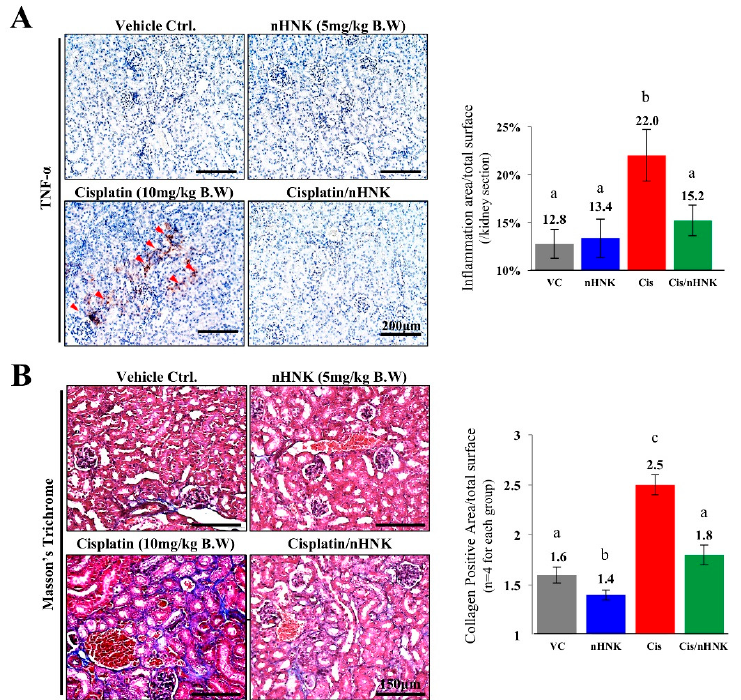
Figure 3. Evaluation of kidney inflammation and collagen deposition. Paraffin-embedded